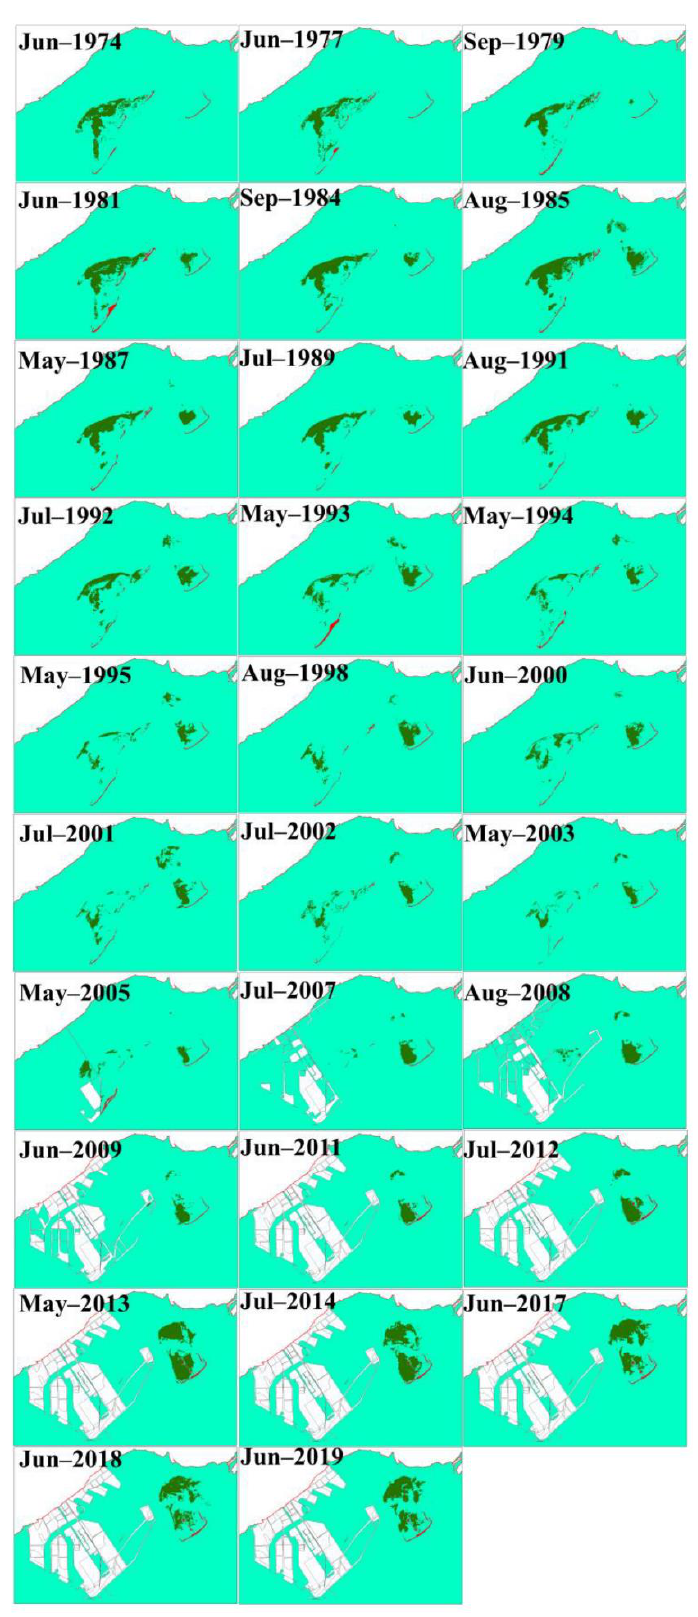
Figure 8. Changes in the spatial distribution of seagrass beds in the study area from 1974 to 2019. In the satellite images, the seagrass beds and unvegetated seawater are represented by green- and cyan-colored pixels, respectively.